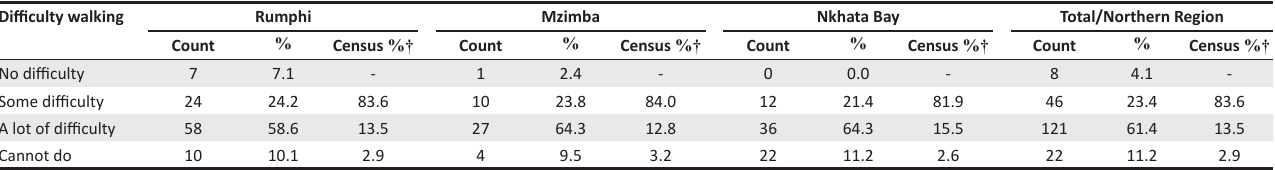
TABLE 2: Difficulty walking, as measured by the Washington Group Extended Set Questions on Disability , in the sample population compared to the general population, by district. Difficulty walking Rumphi